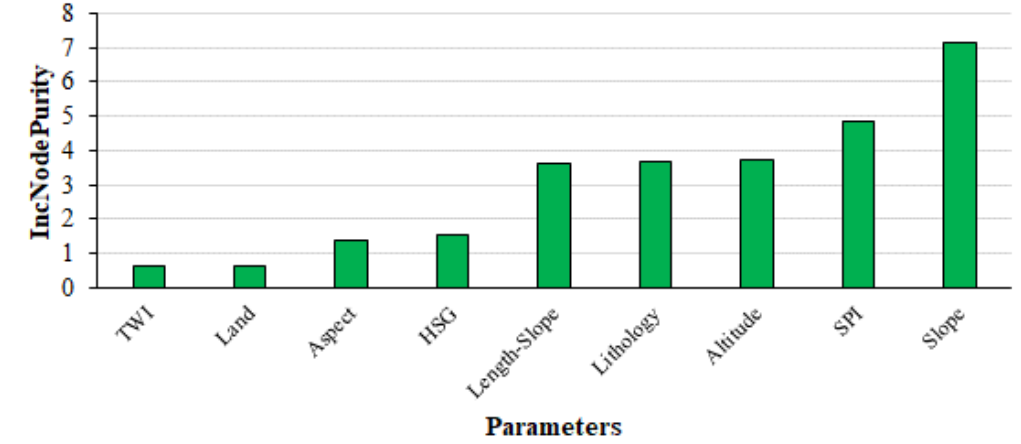
Figure 8. Sensitivity analyzing for each parameter using the IncNodePurity test.